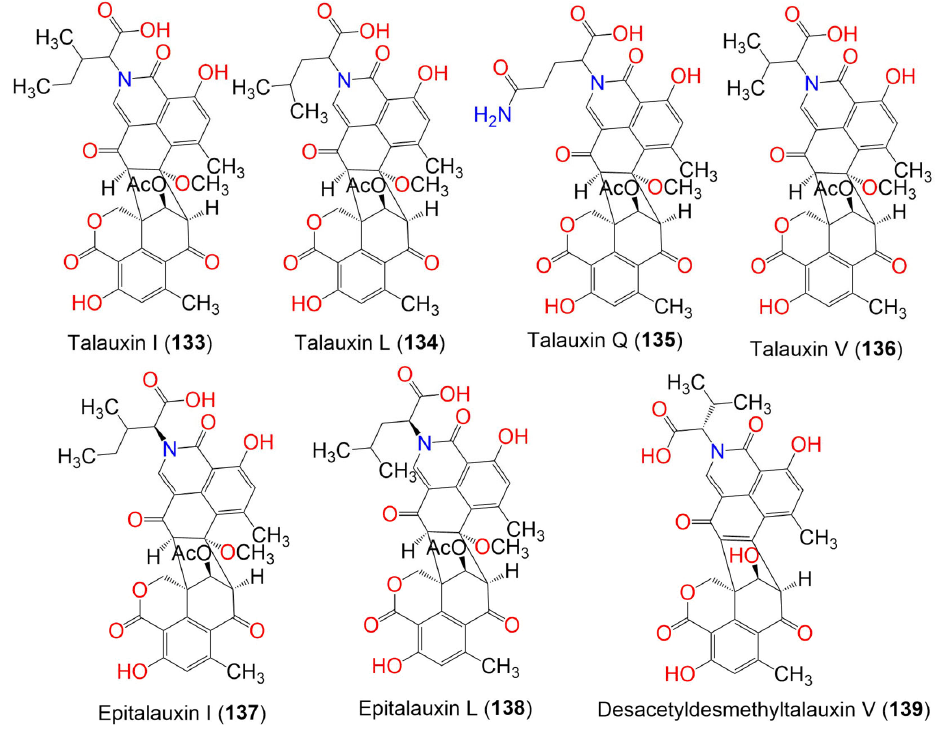
Figure 14. The structures of compounds 133 – 139 .